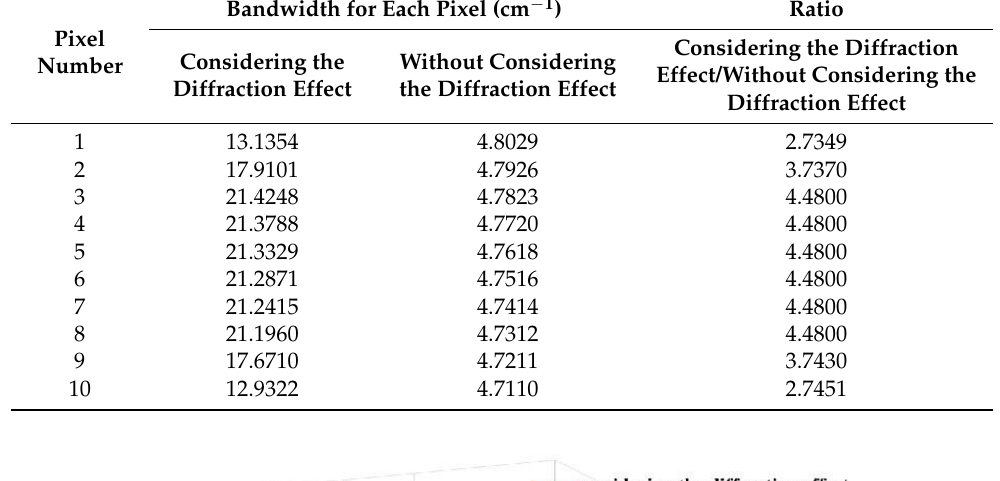
Table 3. Bandwidth comparison for each pixel.